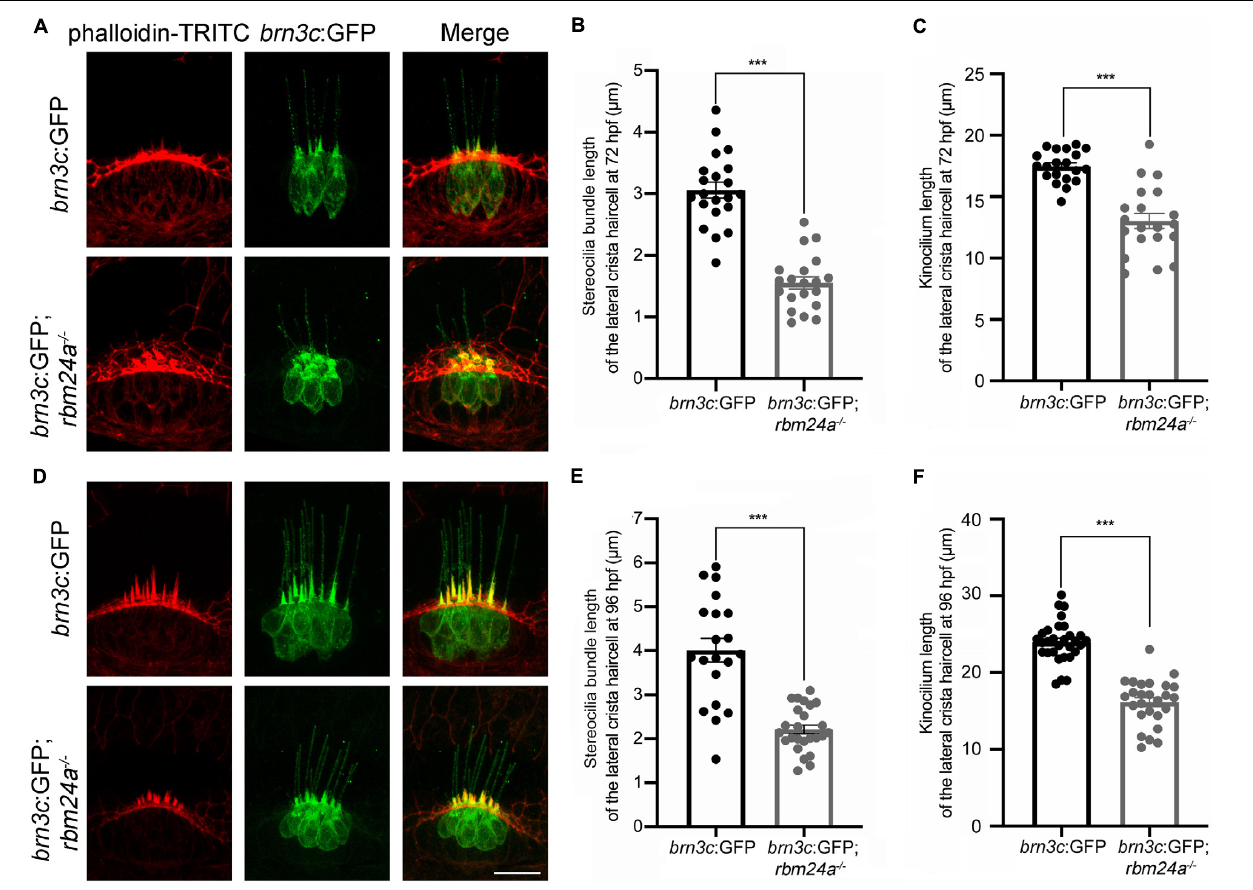
FIGURE 6 | Development of lateral crista hair cells is affected in rbm24a mutants. Confocal microscopic imaging analysis of rbm24a mutant brn3c :GFP line at 72 hpf (A) and 96 hpf (D) . (B,E) Stereocilia length is calculated according to the results from (A,D) , respectively. (C,F) Kinocilia length is calculated according to the results from (A,D) , respectively. For stereocilia length measurement at 72 hpf, brn3c :GFP, n = 21 (from 3 larvae); brn3c :GFP; rbm24a - / - , n = 20 (from 4 larvae). For stereocilia length measurement at 96 hpf, brn3c :GFP, n = 20 (from 3 larvae); brn3c :GFP; rbm24a - / - , n = 25 (from 4 larvae). For kinocilia length measurement at 72 hpf, brn3c :GFP, n = 20 (from 3 larvae); brn3c :GFP; rbm24a - / - , n = 20 (from 4 larvae). For kinocilia length measurement at 96 hpf, brn3c :GFP, n = 30 (from 3 larvae); brn3c :GFP; rbm24a - / - , n = 26 (from 3 larvae). Scale bar, 10 µ m. *** p <